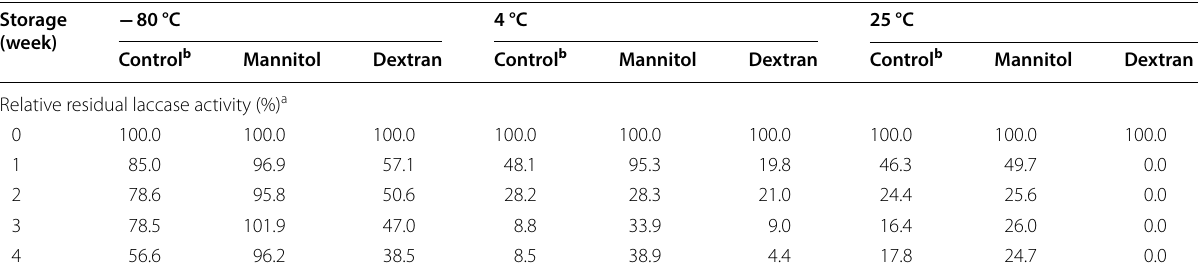
Table 2 Long-term stability of laccase activity of the lyophilized enzymatic extract from Coriolus hirsutus , prepared with 2.5% (w/v) mannitol or dextran 15–25